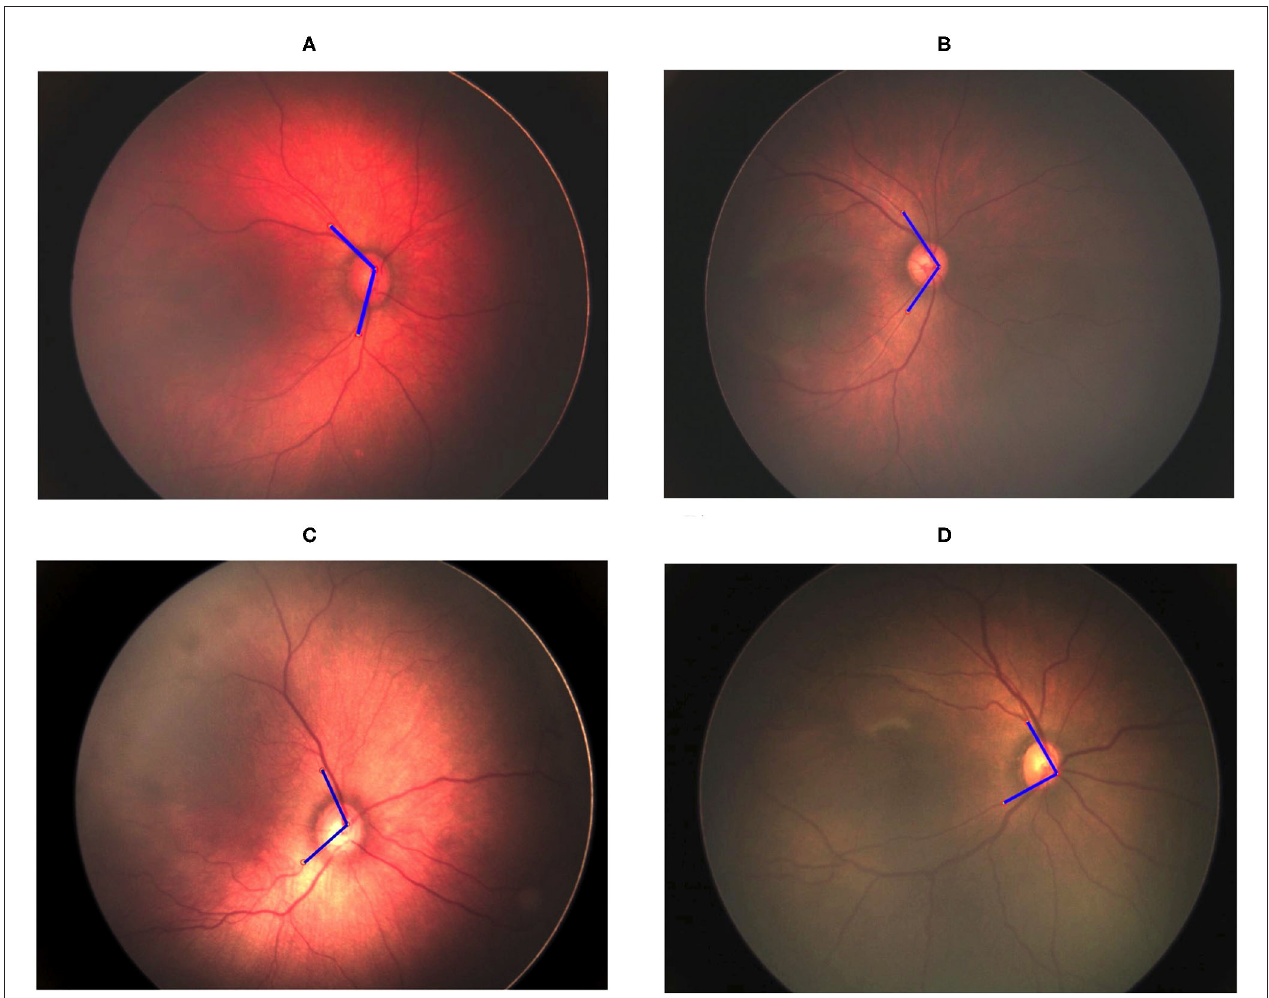
FIGURE 2 | Gradual decrement in TAA from no ROP to stage 3 ROP. (A) No-ROP, (B) stage 1 ROP, (C) stage 2 ROP, and (D) stage 3 ROP groups, with angles 128.60 ◦ , 112.63 ◦ , 107.84 ◦ , and 89.50 ◦ , respectively. The blue lines indicate the direction of temporal retinal